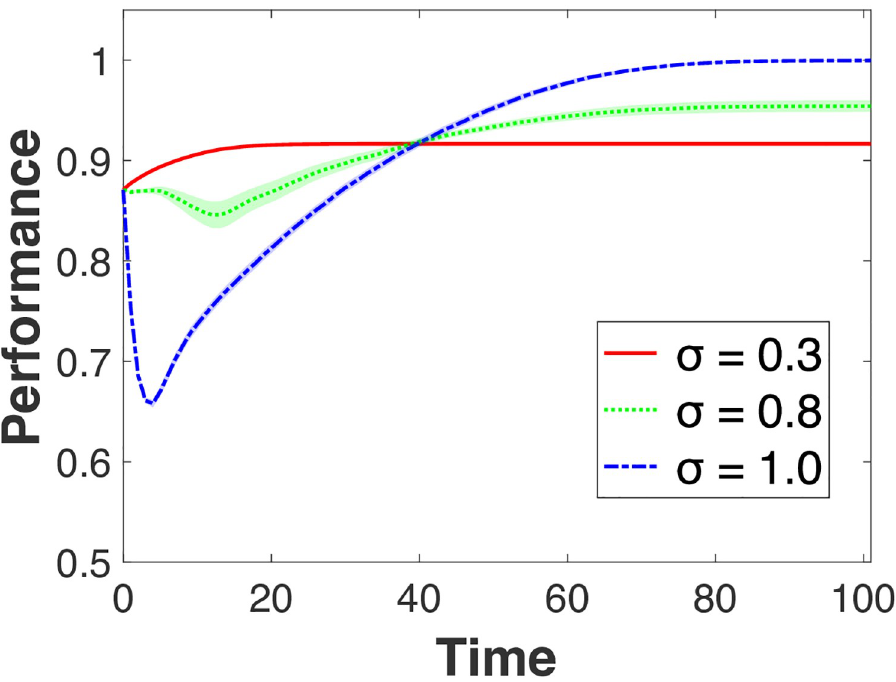
Fig 7. Effects under unequal peak case. The shades represent 95% confidence